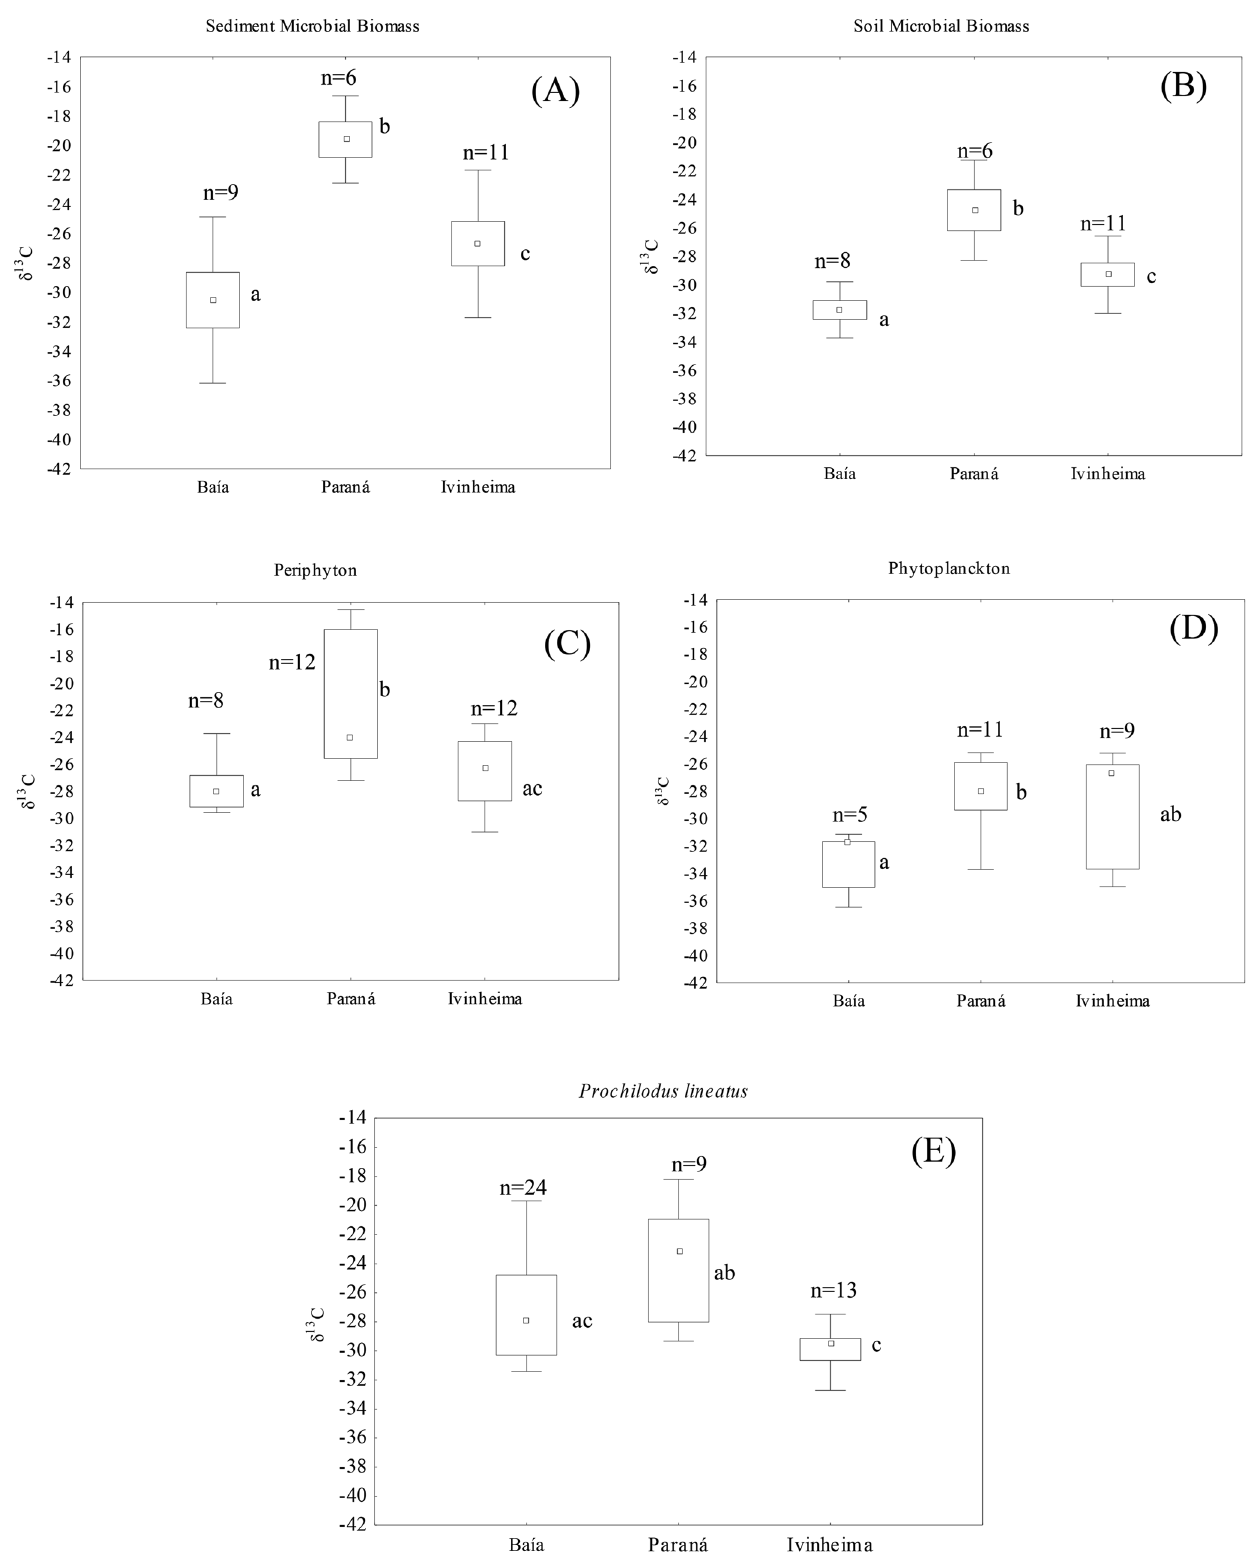
Fig. 3. δ 13C values of food sources (A to D) and of P. lineatus (E). The box-whisker-plots show the lower and upper quartile (25% - 75%), median (□), minimum and maximum (vertical bars). The small letters represent significant differences between the components studied in Paraná, Baía and Ivinheima subsystems of the floodplain of the Upper Paraná River (n = number of